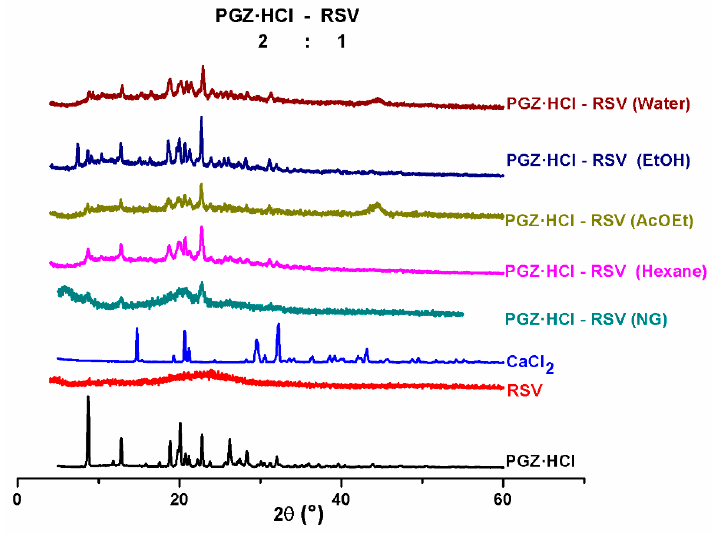
Figure 1. Diffractograms of the solid phases of PGZ · HCl-RSV (2:1) prepared by NG or LAG solvent-screening.